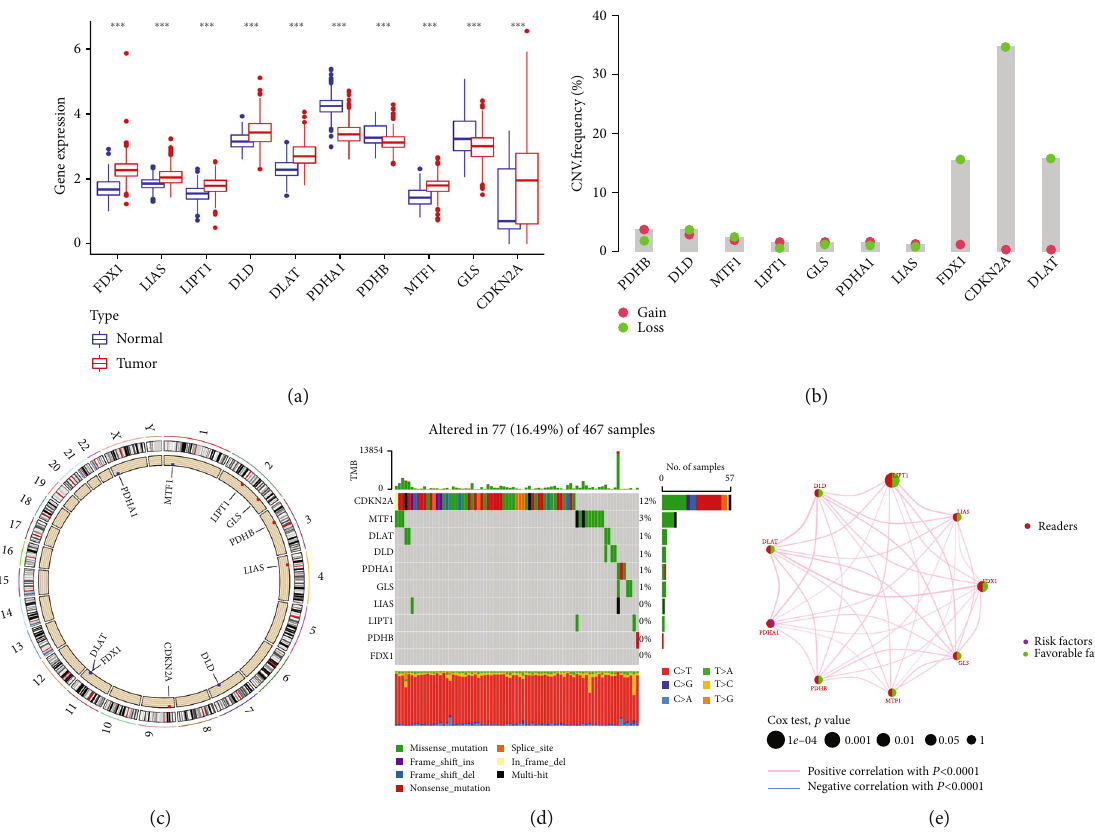
Figure 1: The genetic makeup of CRG variation in CM and its landscape. (a) The expression of 10 CRGs in normal skin tissues compared to that of CM tissues. Normal tissues are shown in blue, while malignant tissues are shown in red ( ∗∗∗ P < 0 : 001 ). (b) The frequency of variations in the CRG copy number. A gain is denoted by the color red, whereas a loss is denoted by the color green. (c) Variation in the copy number of the CRG at various places on the chromosome. The color red indicates that the sample with the increased copy number is larger than the sample with the loss, and it is indicated by the color blue that the sample with the loss is larger than the increase. (d) A waterfall plot depicts the levels of CRG mutations. (e) Diagnostic and prognostic network for the CRGs. Red: “ erasers ” ; orange: “ readers ” ; gray: “ writers ” ; CRG: cuproptosis-related gene; CM: cutaneous